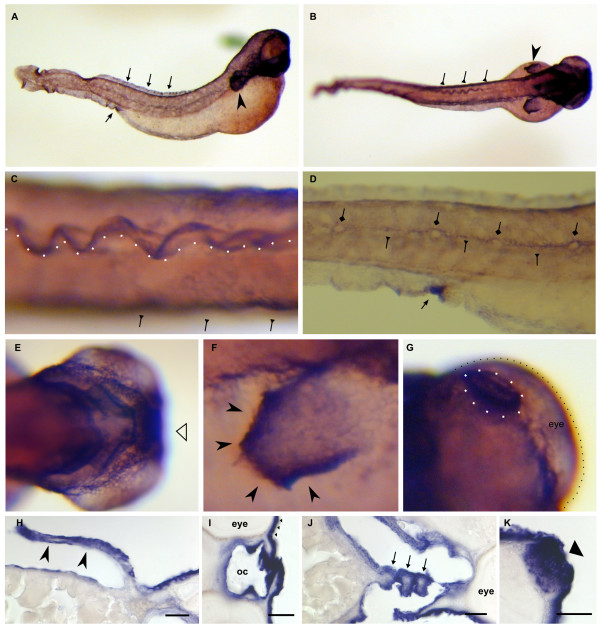
Dr-S100I.1 expression pattern by whole mount in situ hybridization. Five day old zebrafish larvae were hybridized with RNA antisense probe. Panels A) to G), whole mounts; panels H) to K), sectioned after hybridization. Scale bars 30 μm. A) Lateral view, strong ubiquitous expression is seen in the skin, the urogenital opening (bottom arrow), the rim of the dorsal fin (top row of arrows), the pectoral fin (arrowhead) and the lower jaw. B) Dorsal view, strong expression in the pectoral fin, the dorsal fin, and the lateral line (triangle-headed arrows) C) Enlargement of dorsal view, expression in the lateral line (arrows) and the dorsal fin (rim indicated by white spots). D) Larger magnification of urogenital opening (arrow) and the labeled lateral line (triangle-headed arrows) surrounding the neuromasts (diamond-headed arrows), which are not labeled. E) Ventral view, strong expression in branchial arches is seen. F) Enlargement of pectoral fin, especially the rim is heavily labeled. G) Dorsal view, expression in the olfactory placode (white dots). H) Cross section of the pectoral fin. I) Pharynx is intensely labeled. J) Three branchial arches (asterisks) are cross-sectioned; the mesenchyme including the cartilaginous bar is devoid of staining. K) The olfactory placode is heavily stained.